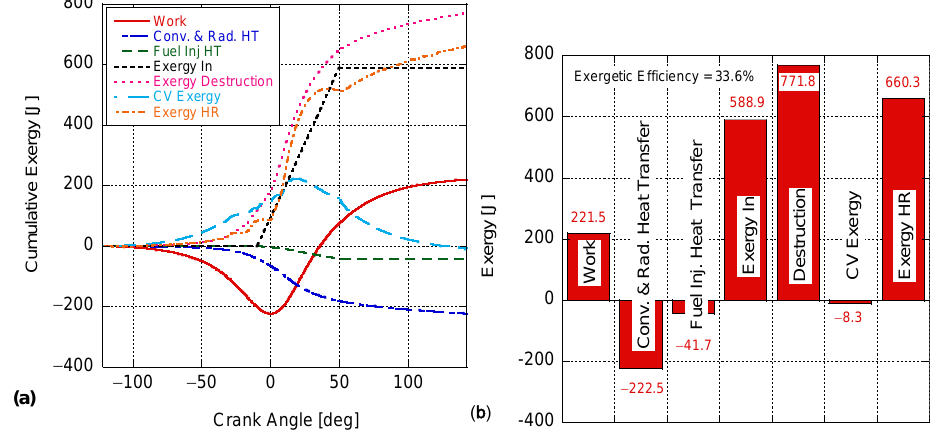
Figure 15. ( a ) Cumulative exergy as a function of crank angle and ( b ) the results of the different components in the exergy equation.